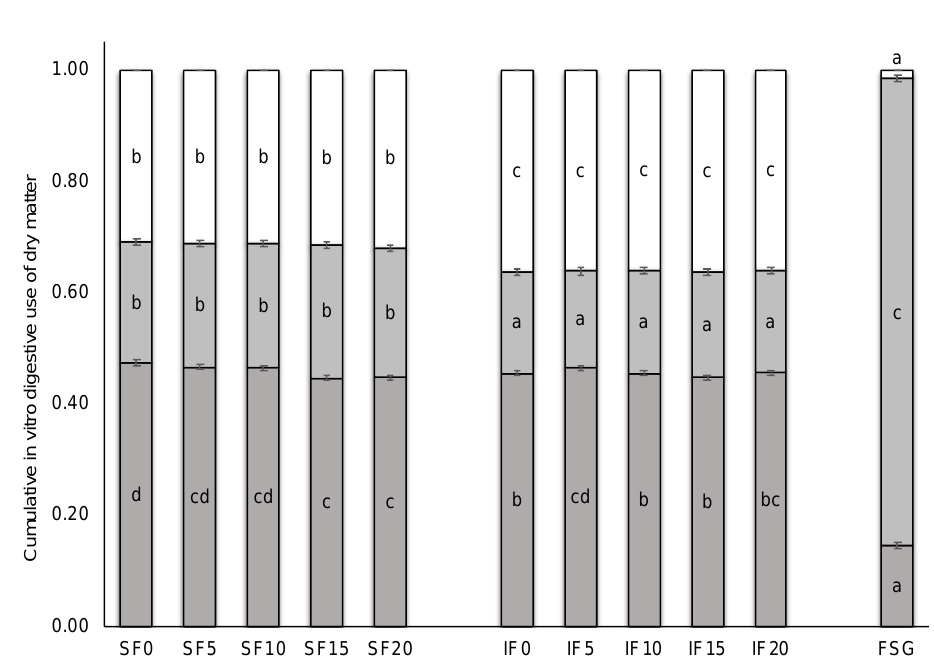
Figure 1. Effect of fenugreek seed gum (FSG) level of inclusion in the experimental diets (SF and IF) on their cumulative in vitro digestive use of dry matter (DM): digested faction (dark grey), fermented fraction (light grey) and fraction neither digested nor fermented (white). FSG, pure fenugreek seed gum; SF0, SF5, SF10, SF15 and SF20, SF diet with 0, 5, 10, 15 and 20 g of FSG included per kg of feed; IF0, IF5, IF10, IF15 and IF20, IF diet with 0, 5, 10, 15 and 20 g of FSG included per kg of feed. a,b,c,d Bars for each fraction not sharing a letter were significantly different at p < 0.05.